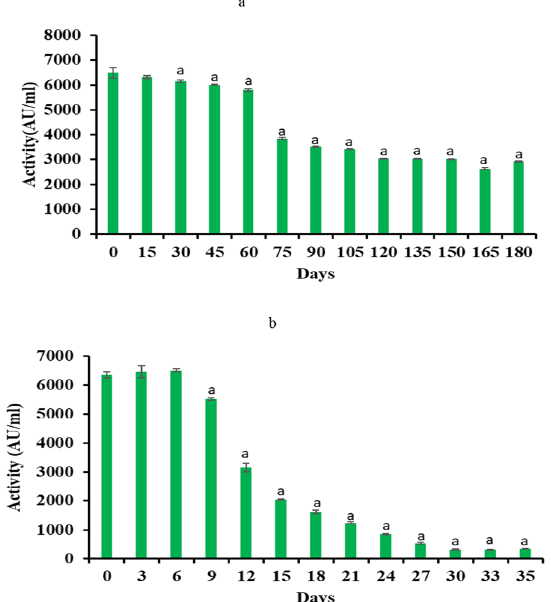
Fig.4 Stability profile of crude ESmr18 stored at (7–8 °C) ( a ) in distilled water ( b ) sodium acetate buffer and tested in terms of its antimicrobial activity against S. enterica . Error bars are representative of mean SD of the experiment performed in triplicates. a Indicates ± data significantly (p < 0.05) different from the activity on day 0